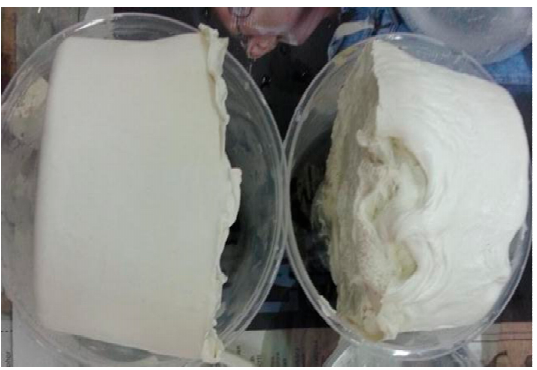
Figure 10. Formation of big lumps of NRL after the freeze–thaw processes at 0 phr AG loading. A loading of 0.2 phr AG gave the best results before freezing and after the freeze–thaw processes, as it had zeta potentials of − 59.63 mV and − 56.27 mV before freezing and after freeze–thawing, respectively (nanoparticles with zeta potentials of greater than +30 mV or less than − 30 mV are considered strongly cationic or strongly anionic,